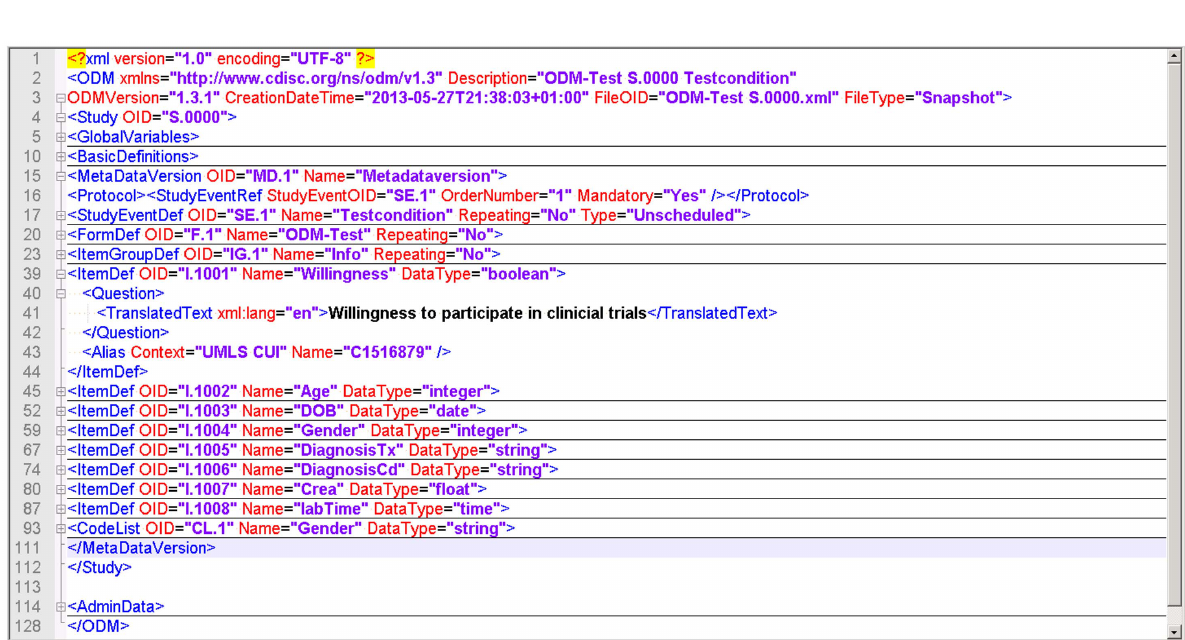
Figure 1. Example of data model in CDISC ODM-format. It consists of one form (‘‘ODM-Test’’) with one itemgroup (‘‘Info’’) and 8 data items. Details for item I.001 are displayed, including item name, detailed description in english and its associated UMLS